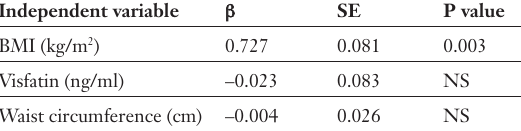
Regression analyses When log visfatin was taken as a dependent variable and other parameters as independent variables, significant relationships of log visfatin to weight (r = 0.507; p = 0.004), waist circumfer- ence (r = 0.490; p = 0.006), hip circumference (r = 0.425; p = 0.019) and BMI (r = 0.528; p = 0.003) were found in the obese group (p <0.05) by linear regression analysis. Multivariate regression analy- sis revealed significant relationships of log visfatin as dependent variable to BMI (p = 0.005) and bodyweight (p = 0.014) as independent variables.